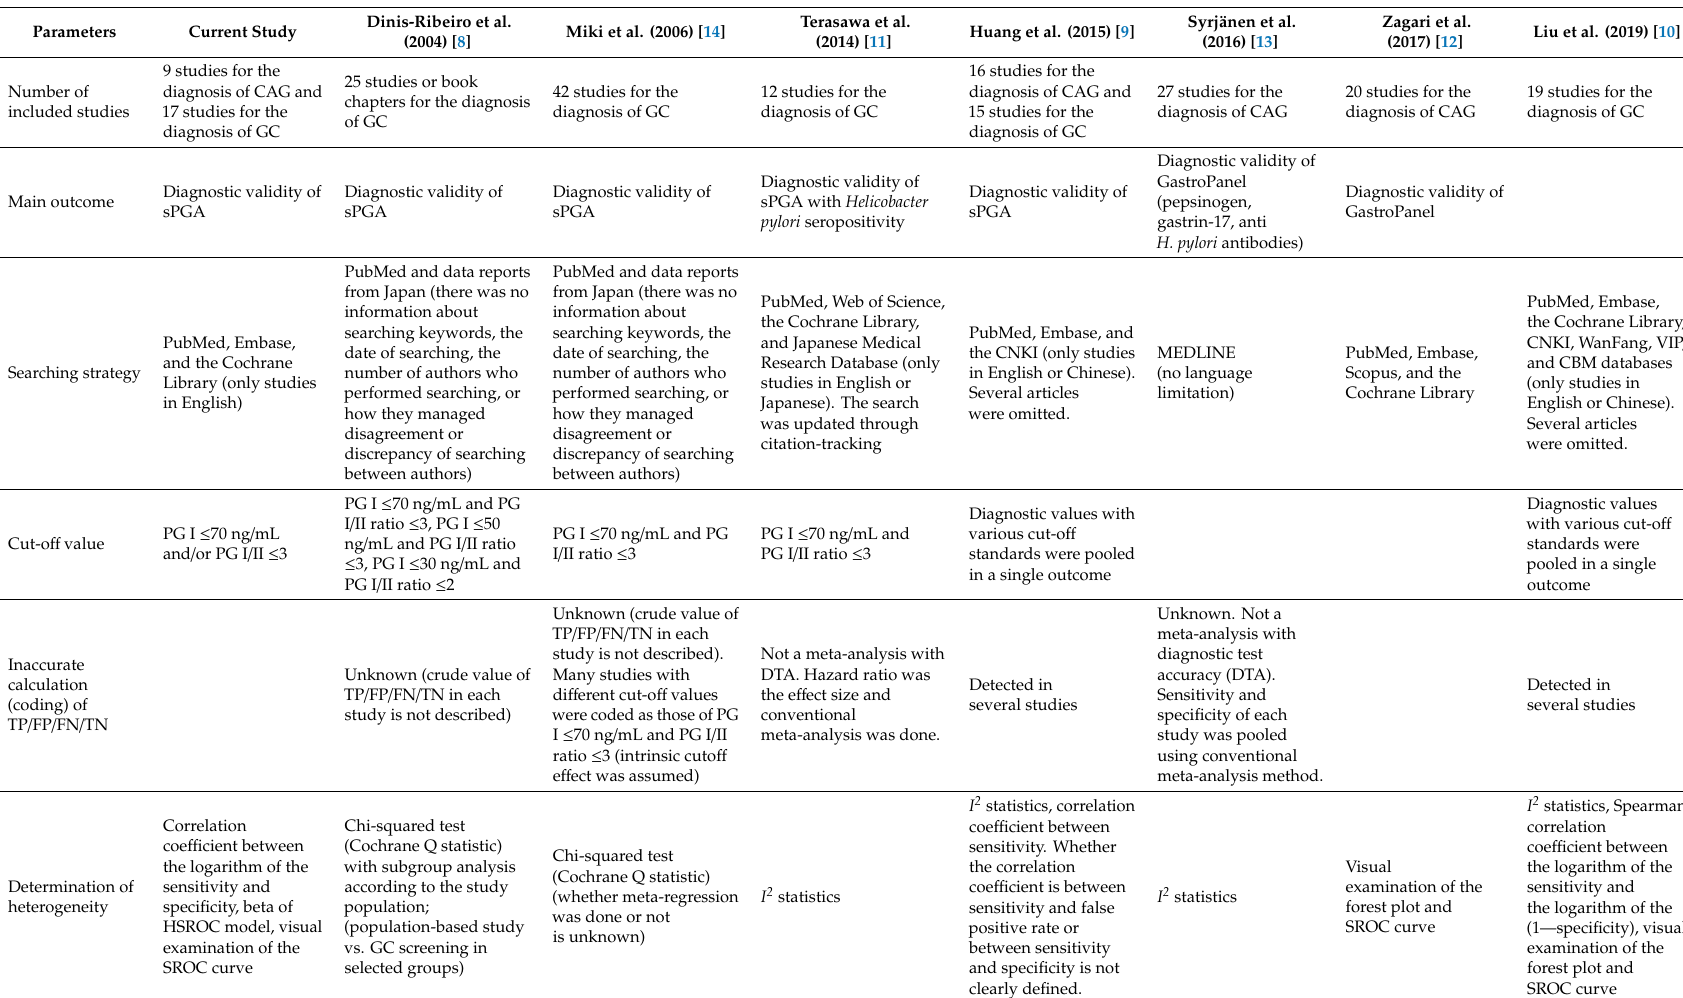
Table 1. Comparison of previous meta-analyses with current